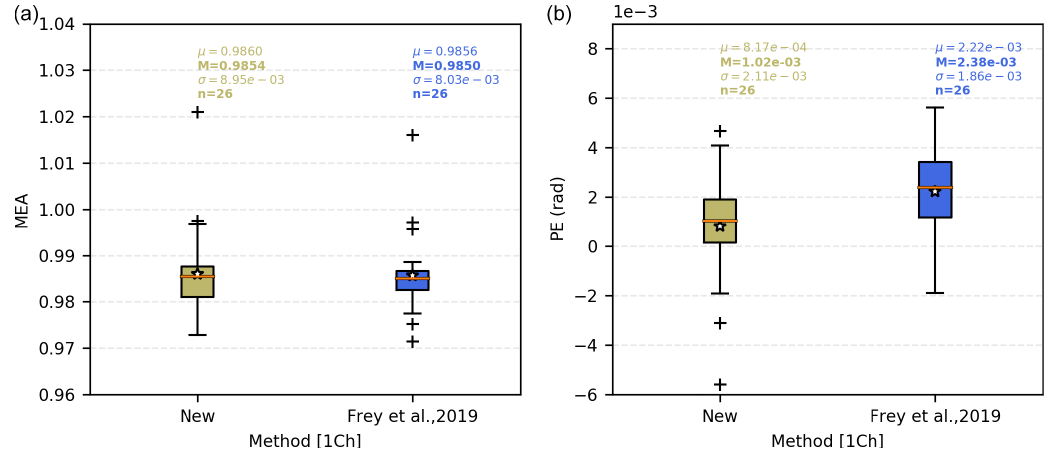
Figure 9. Box-and-whisker plots showing the statistics of the original data analysis by Frey et al. (2019) and the reanalysis: median, mean, scatter and interquartile range are presented. (a) MEA. (b)